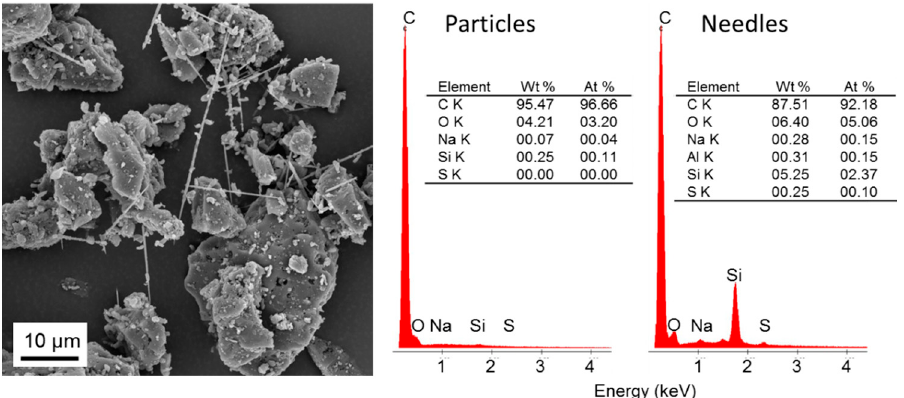
Figure 3. SEM image of carbonised lignin containing small amounts of needle-shape crystals ( left ) and results of EDX analyses ( right ) of both carbon particles and crystals.